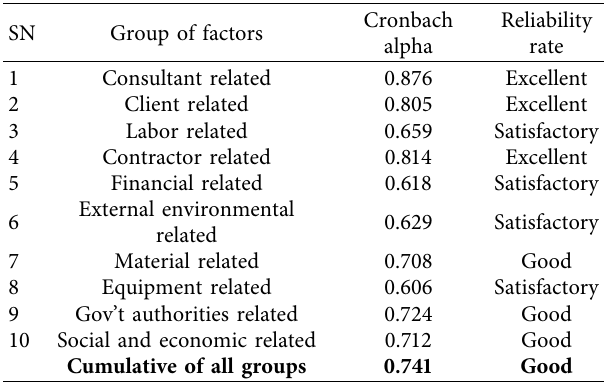
Table 5: Reliability